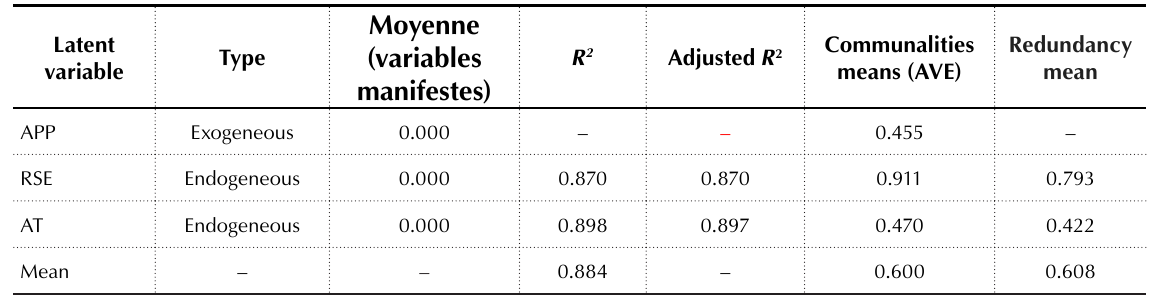
Table 7. Model evaluation